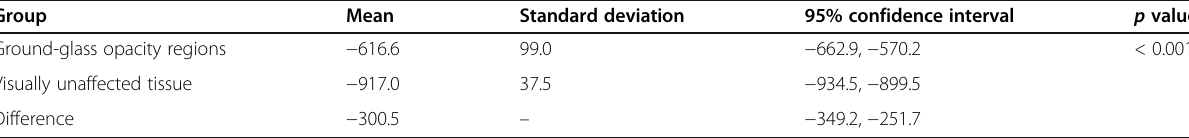
Table 1 Density values of the ground-glass opacities and visually unaffected tissue and their difference from 22 clinical images